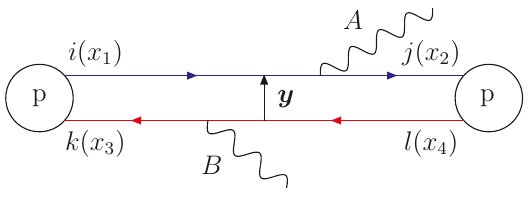
Figure 1 . Sketch of a DPS at a pp collider leading to the production of the (cid:12)nal state A + B . The transverse distance y between the partons is